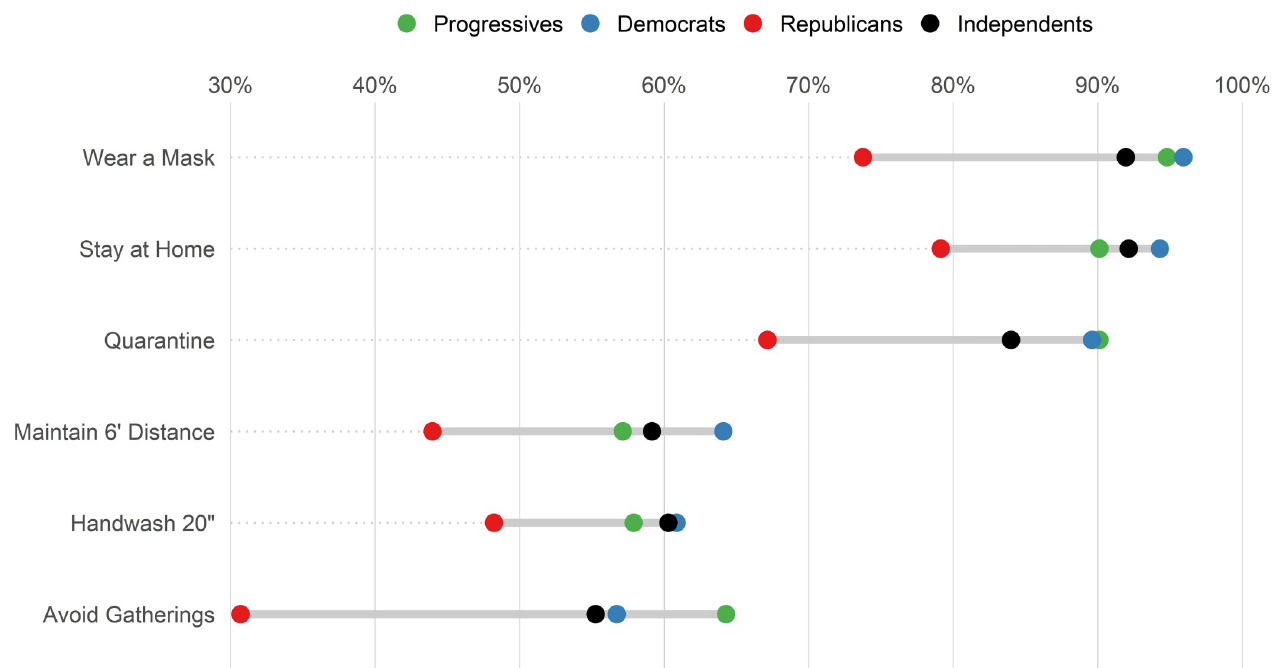
Fig 2. Percent of Vermont respondents who reported always following recommended actions to prevent COVID-19 infection, delineated by self- identified political party affiliations, January–April 2021.